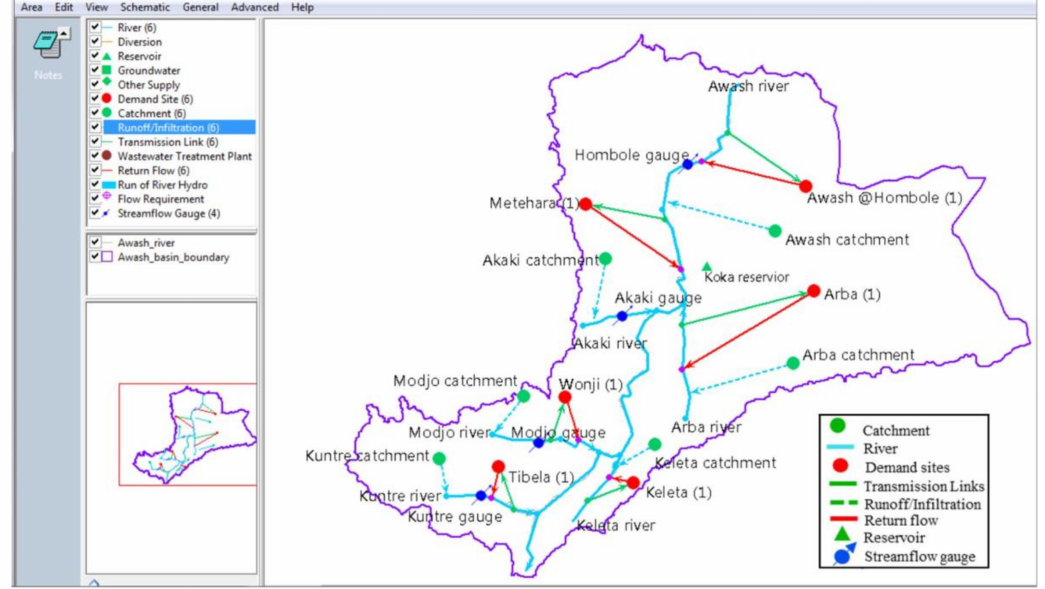
Figure 4. A snapshot of the WEAP model configuration showing the demand sites in the Awash River